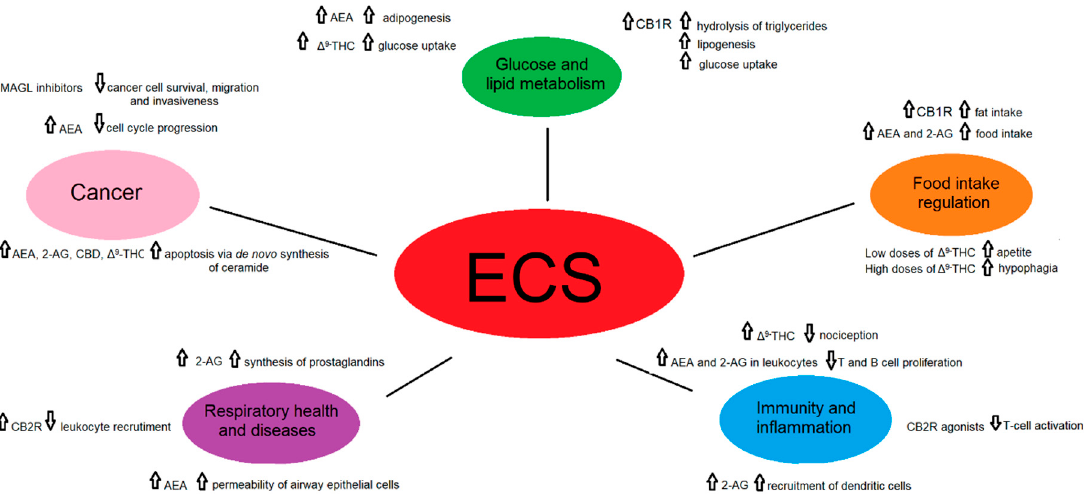
Figure 3. A schematic representation of the role of the endocannabinoid signaling in selected physiological and pathologi- cal states.